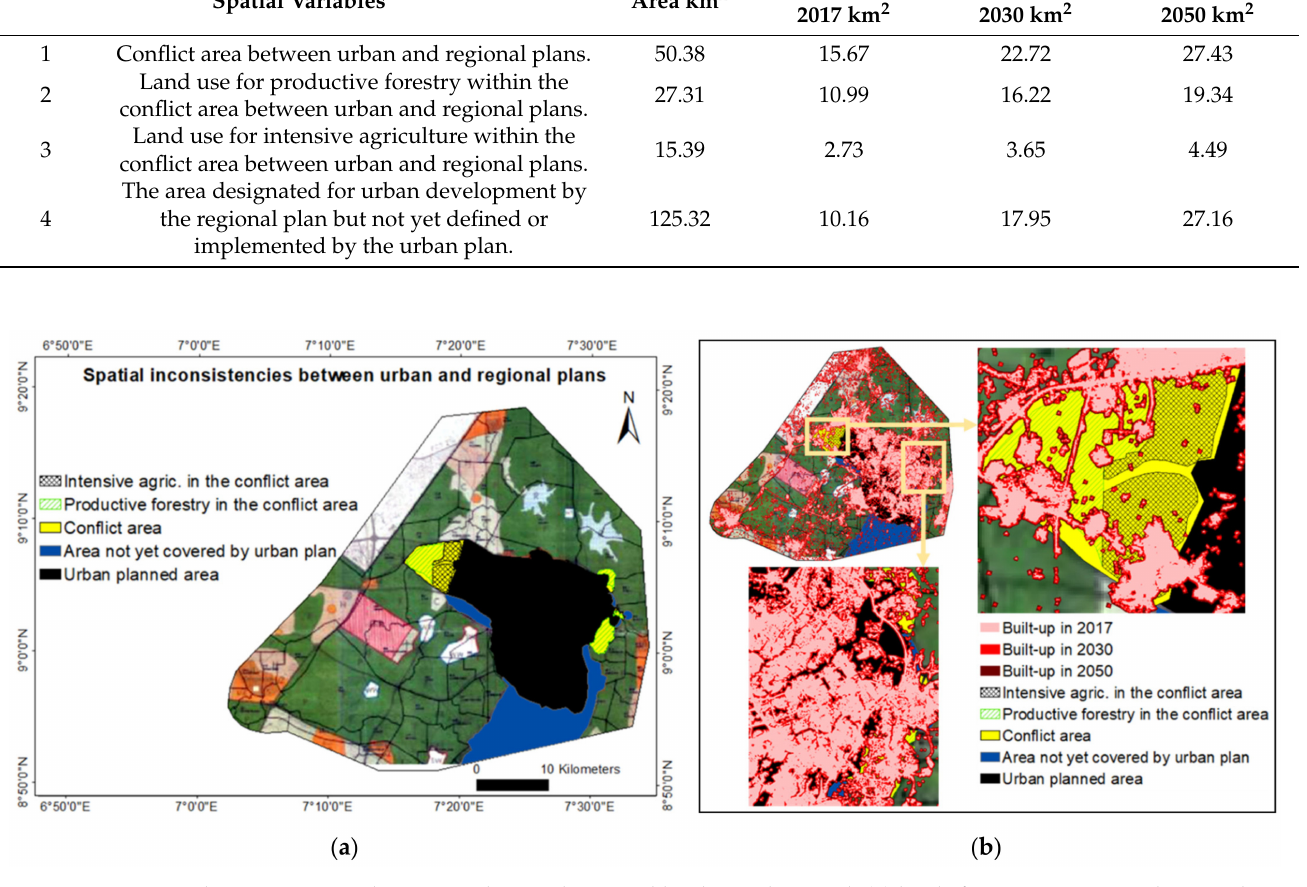
Figure 3. Spatial inconsistencies between urban and regional land use plans with ( a ) lands for intensive agriculture and productive forestry in the conflict areas and ( b ) built-up area